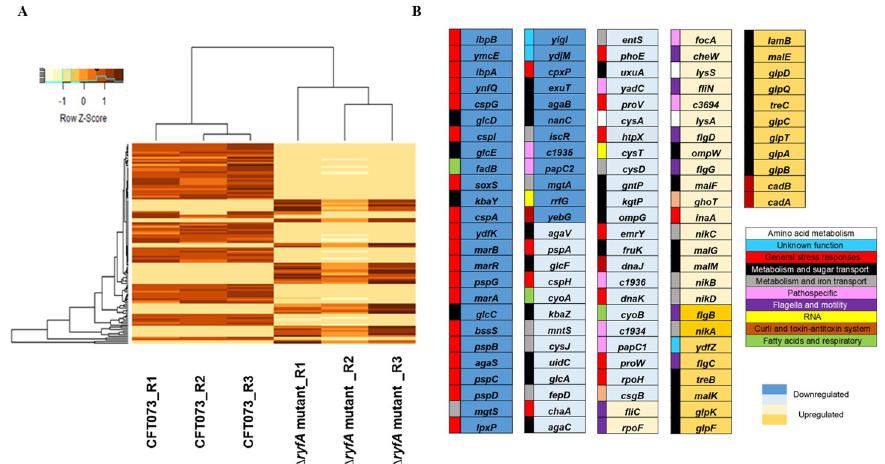
Fig 3. Genes significantly affected by deletion of ryfA . RNA-seq analysis was performed on RNA samples (in triplicate) from strain CFT073 and CFT073 Δ ryfA grown in LB at mid-log phase of growth (O.D. 0.6). ( A ) Heatmap of the entire data set (n = 6) of CFT073 and Δ ryfA mutant. Each row of the heatmap represents the log2 fold values transformed with Z-score of 121 differentially expressed genes (upregulation, red, downregulation, yellow). Hierarchical grouping of differentially expressed genes shows clustering. Z-scores are computed on a gene-by-gene basis by subtracting the mean and then dividing by the standard deviation. Specific genes and changes are presented in Fig 3B. ( B ) Genes classified in different categories based on log2 fold-change difference. Genes upregulated (yellow rectangles) and downregulated (blue rectangles) by at least 1.7-fold were considered significant with P < 0.05. Dark blue is greater or equal to ( � ) a 3-fold decrease. Light blue is a decrease from 3-fold to 1.7-fold. Light yellow is an increase from 1.7-fold to 3-fold. Dark yellow is a greater or equal to ( � ) 3-fold increase. Genes are classified in different categories with colored squares: General stress responses in red, metabolism and sugar transport in black, metabolism and iron transport in grey, patho-specific in pink, flagella and motility in purple, fatty acids and respiratory chain in green, amino acid metabolism in white, curli and toxin-antitoxin system in orange, RNA in yellow and unknown function in azure. Specific values fold-changes are presented in S1 Table (see supplementary data).